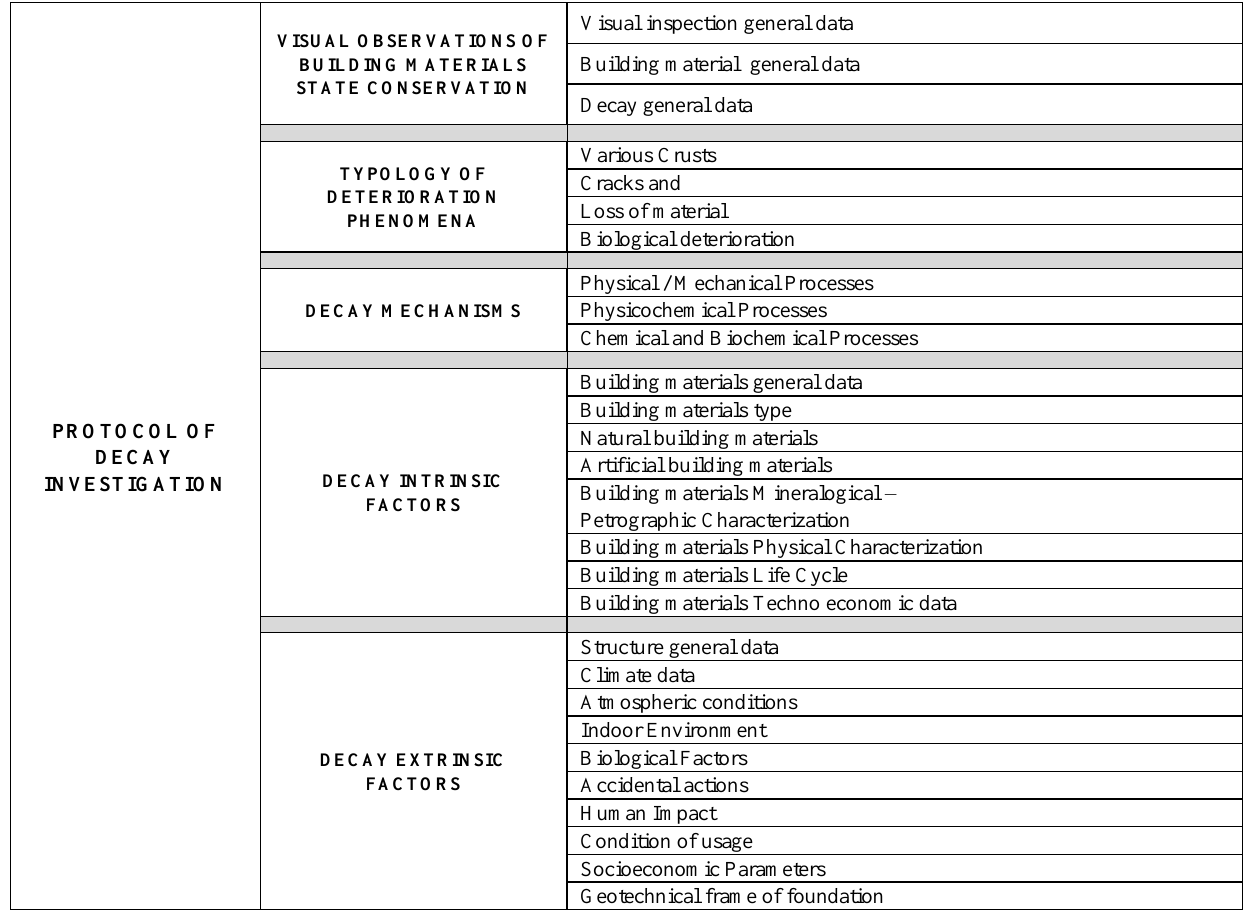
Table 1. Protocol of Decay